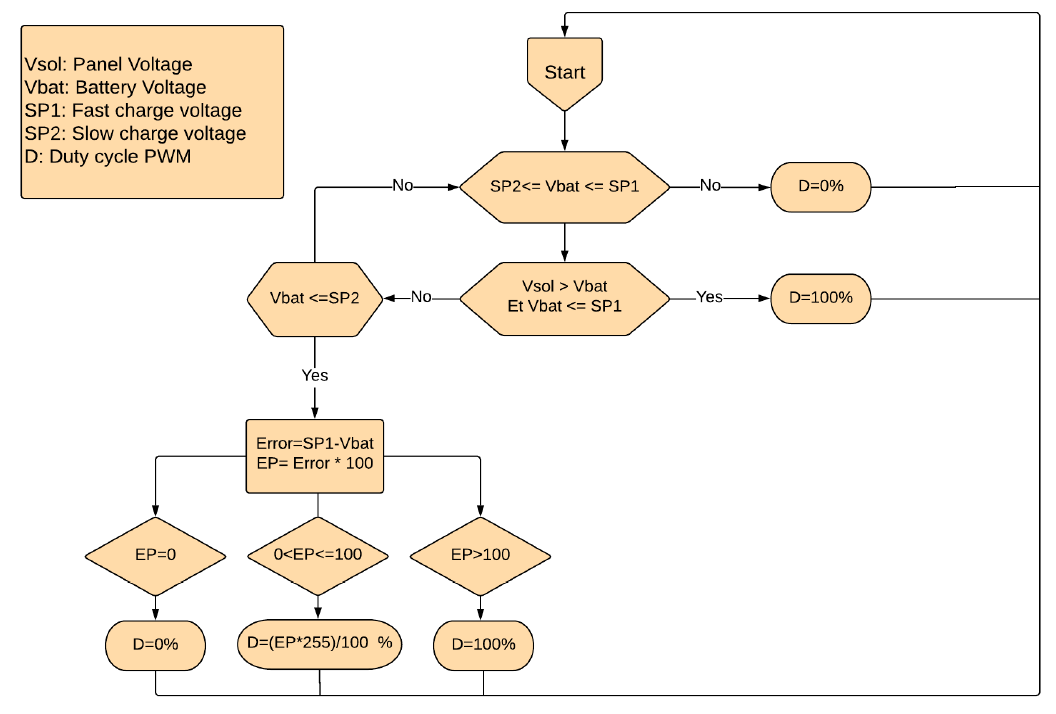
Figure 3. PWM algorithm.